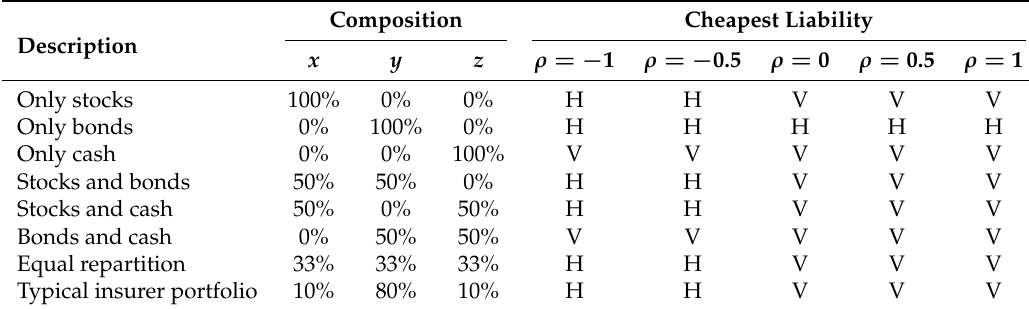
Table 4. Results of the ALM comparison for some example portfolios. The cheapest liability is the horizontal one when H is displayed, and the vertical one when V is displayed.